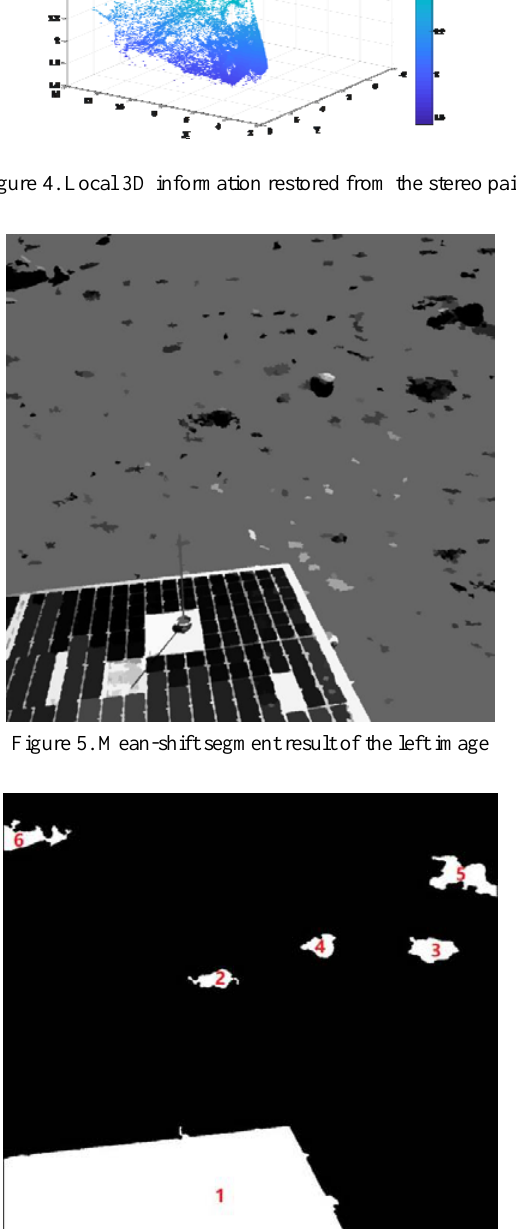
Figure 3. Feature point extraction and matching results